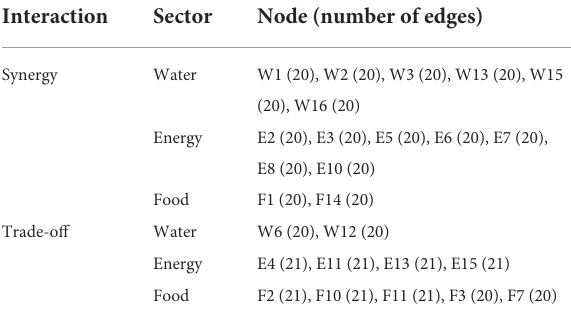
TABLE 3 Top 10 indicators with nodes having 20 or more edges in Figure 4.